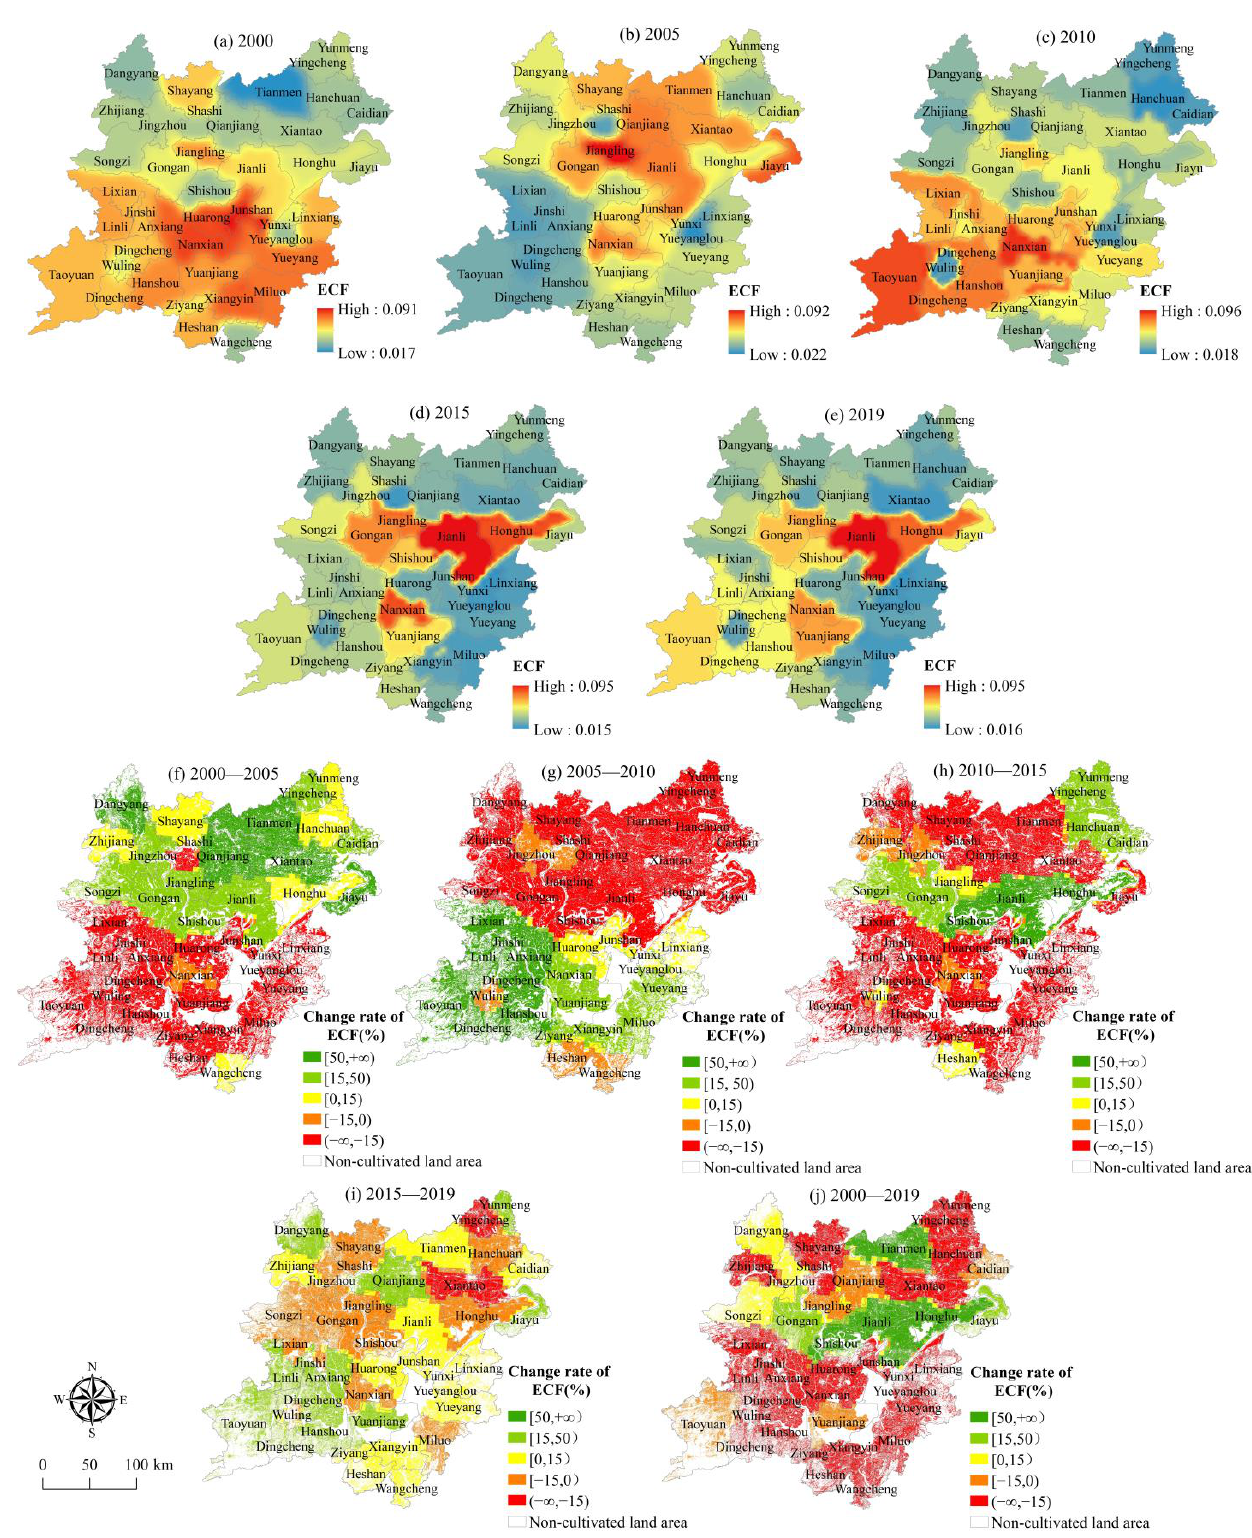
Figure 7. Spatial distribution of economic contribution function index.